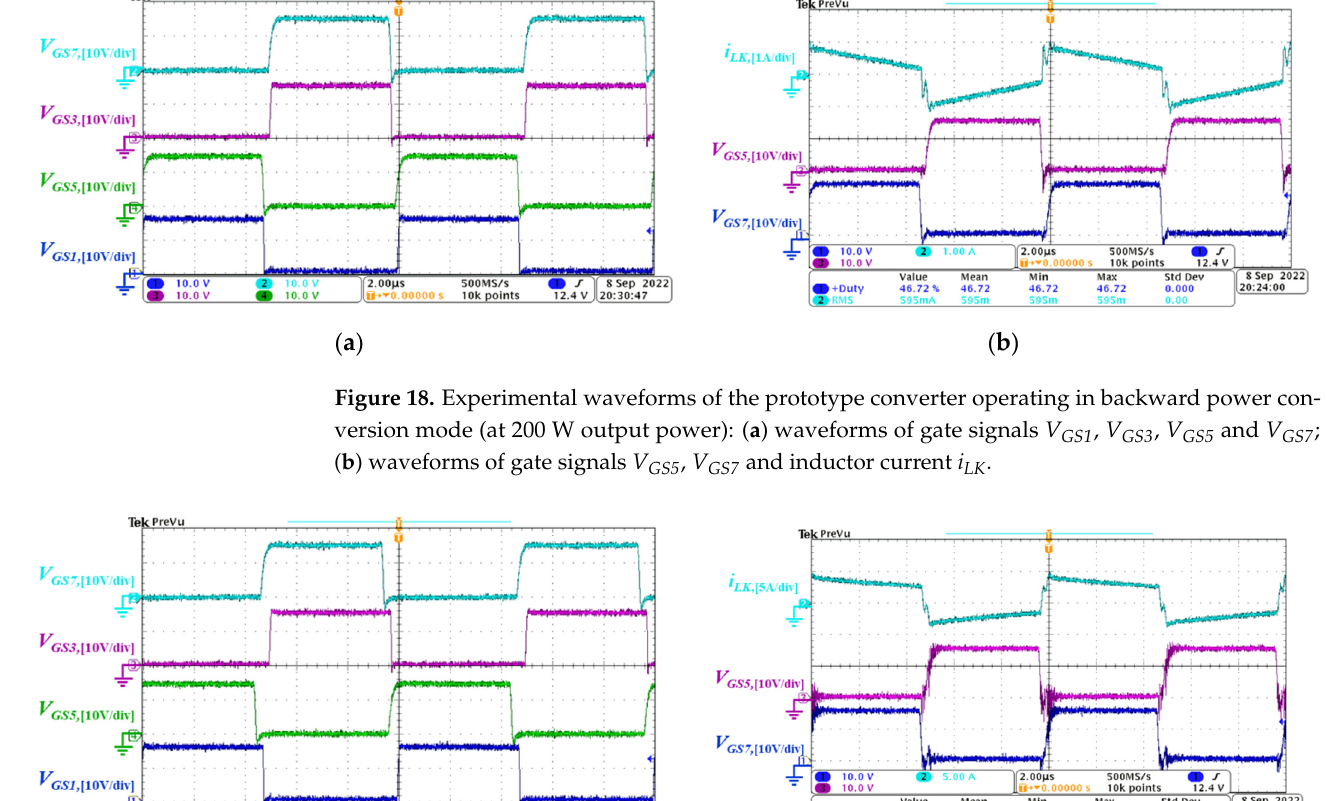
Figure 17. Experimental waveforms of the prototype converter operating in backward power con- version mode (at 100 W output power): ( a ) waveforms of gate signals V GS1 , V GS3 , V GS5 and V GS7 ; ( b ) waveforms of gate signals V GS5 , V GS7 and inductor current i LK .